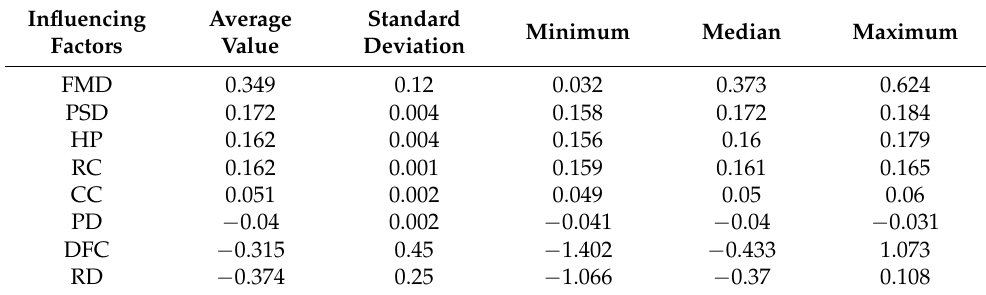
Table 7. Statistics of the regression results of the MGWR